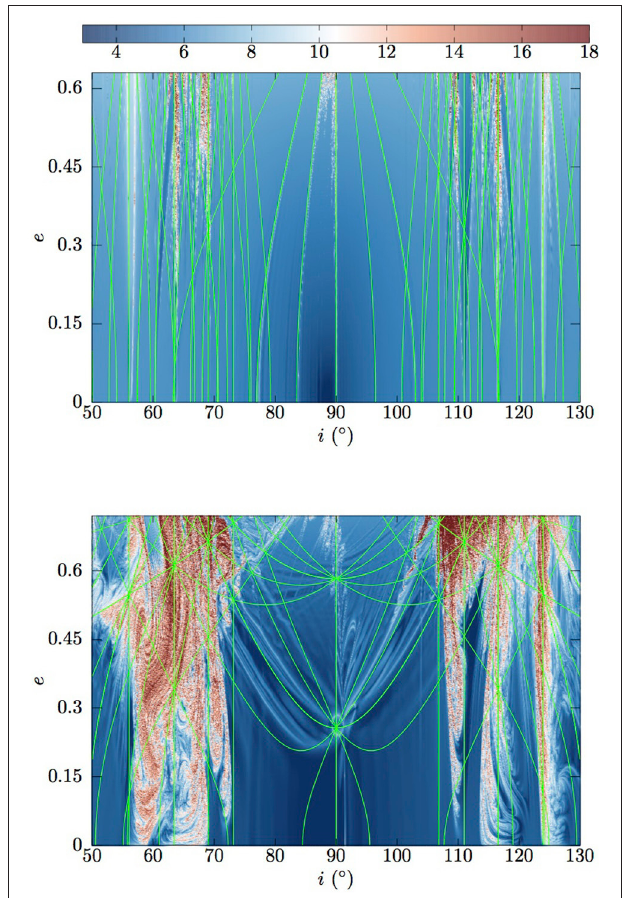
FIGURE 3 | Detailed views of the prograde and retrograde regions for the two-extreme values of the parameter ε considered in this work ( Top a 18,600 km, Bottom a 29,600 km). The resonant manifolds defined by = = Equation (2.12) are superimposed on the FLIs. Despite the symmetry of the resonant manifolds, the chaos of the prograde region is not mirrored in the retrograde region.